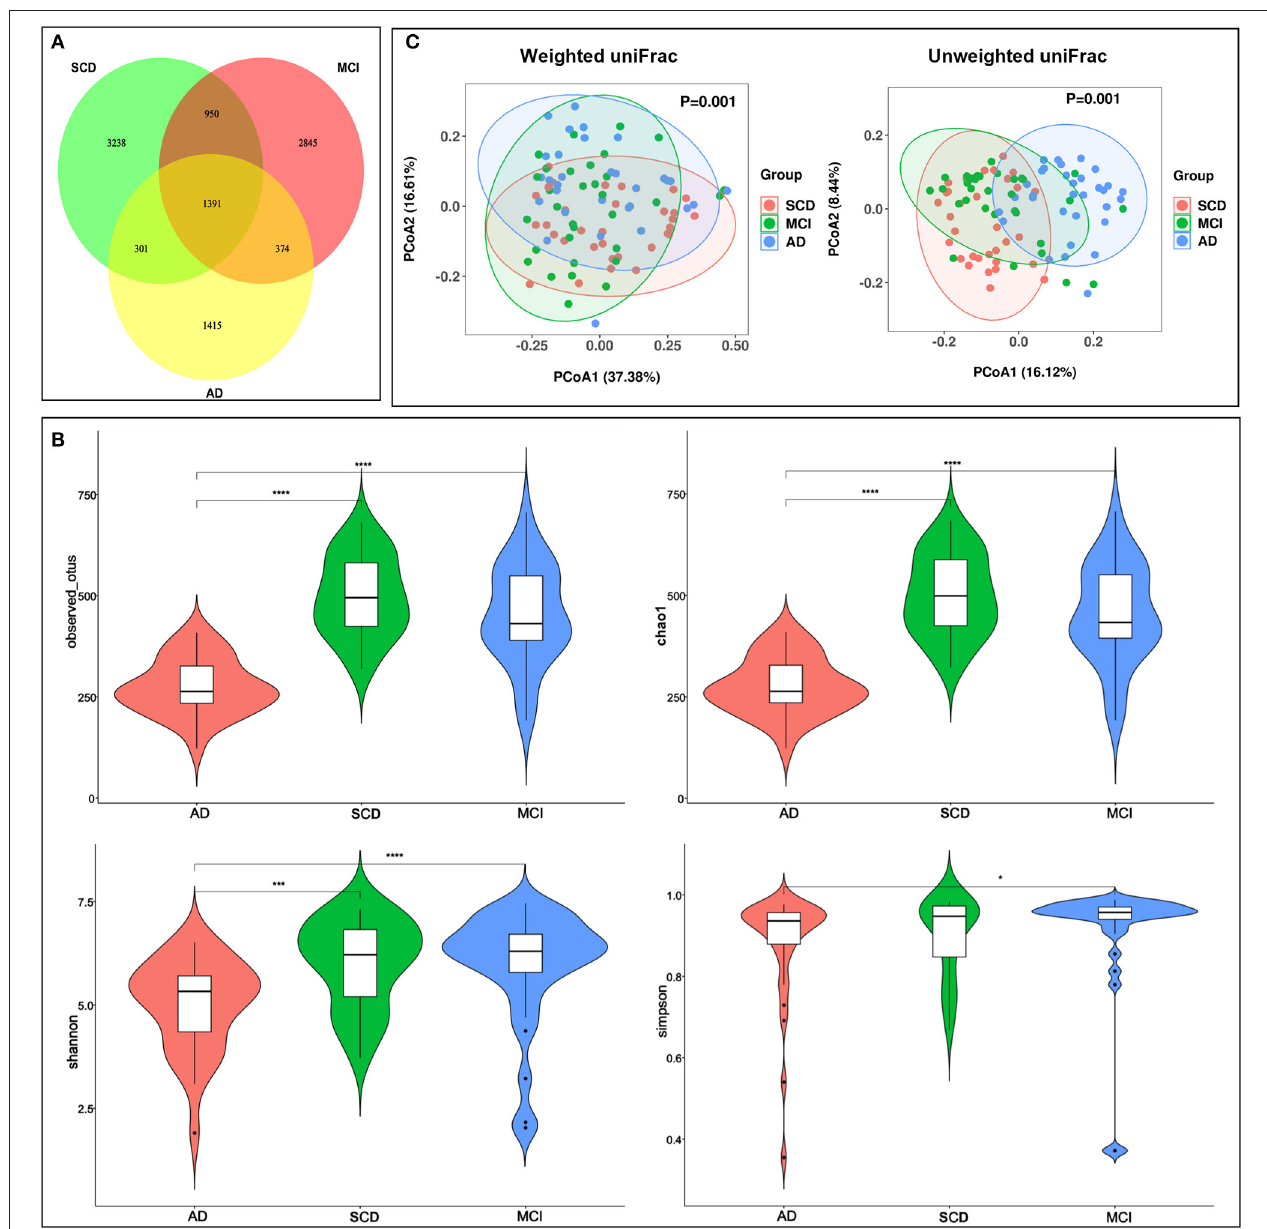
FIGURE 3 | Bacterial diversity of the oral microbiota of SCD, MCI and AD groups. (A) A feature venn diagram among three groups. (B) The α -diversity of the oral microbiome among three groups according to observed-otus, Chao 1, Shannon index, and Simpson index. (C) The beta diversity was calculated using weighted ( P = 0.002) and unweighted UniFrac ( P = 0.001) by PCoA. **** P < 0.0001, *** P < 0.001, * P <